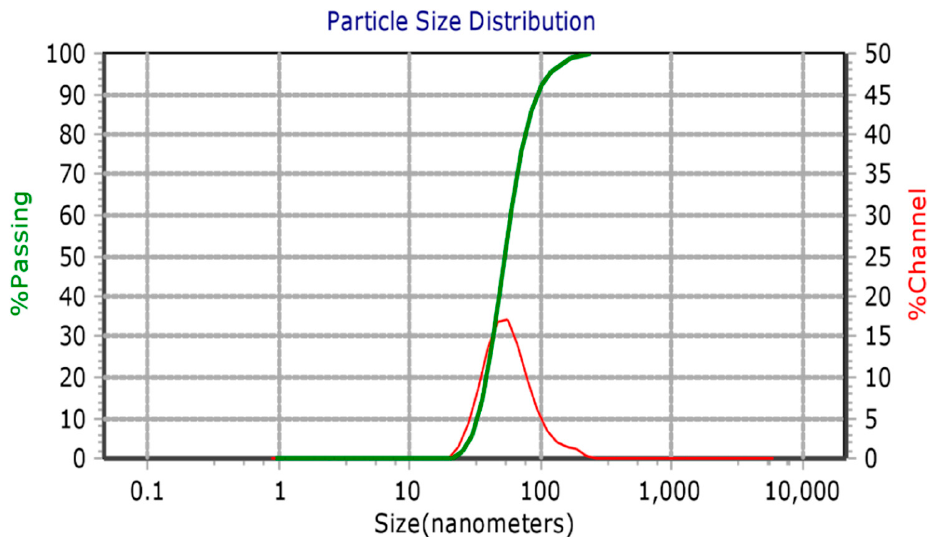
Figure 3. PSA of biosynthesized AgNPs .